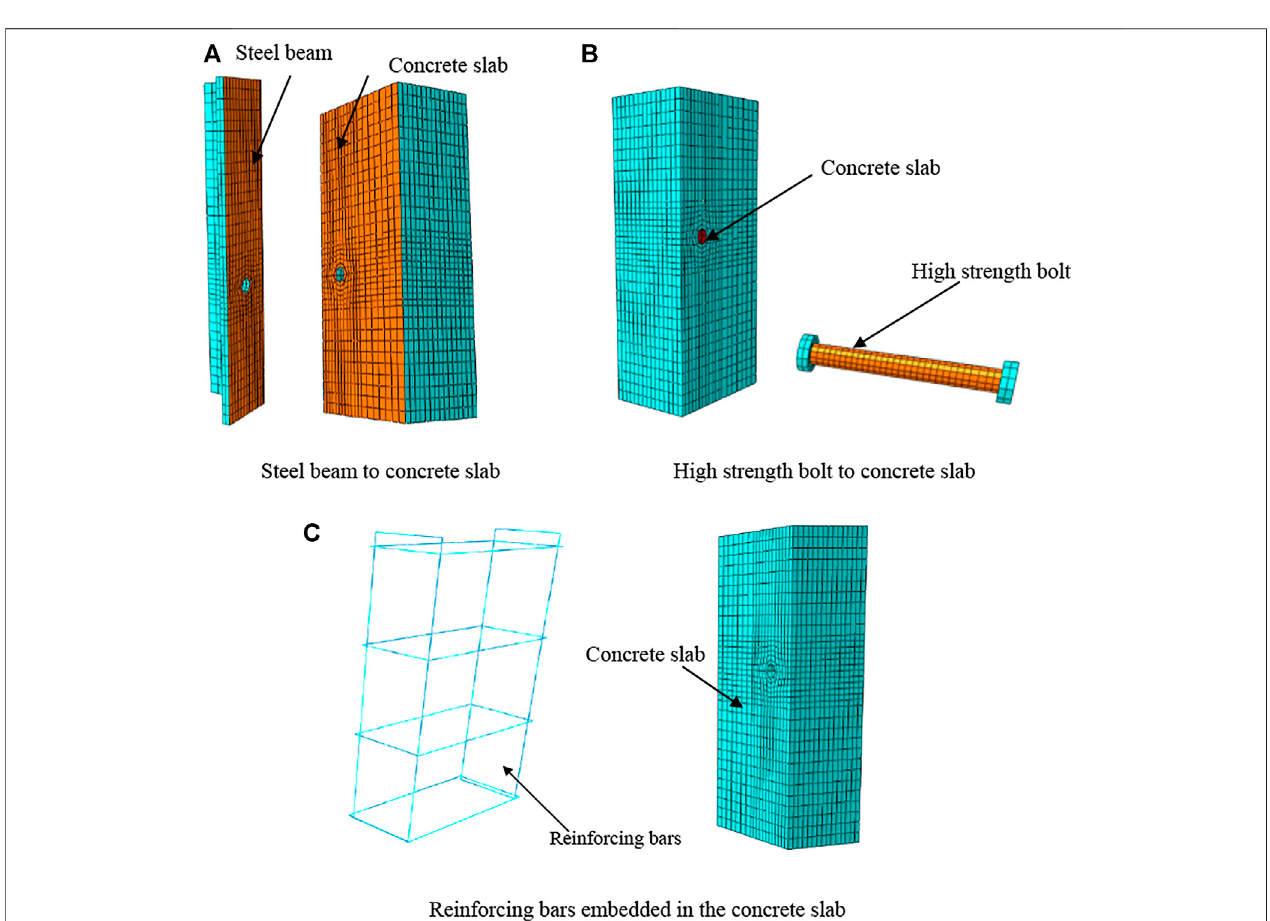
FIGURE 2 | Contact details of the developed FEMs.